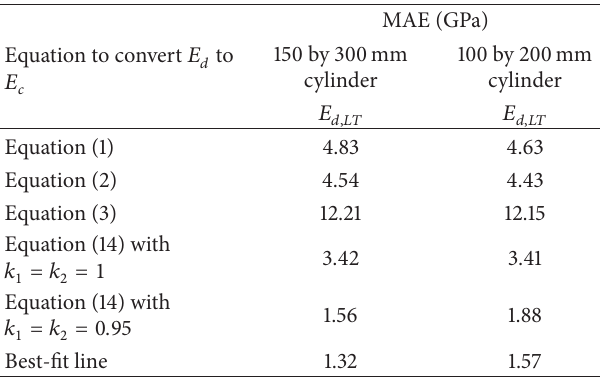
Table 3: Mean absolute error (MAE) of expressions relating static elastic modulus and compressive strength measured using 100 by 200 mm and 150 by 300 mm